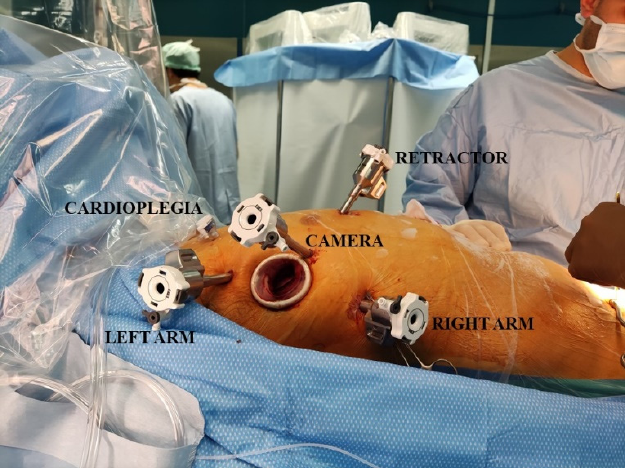
Figure 1. This picture shows the operative setting and the insertion sites of the